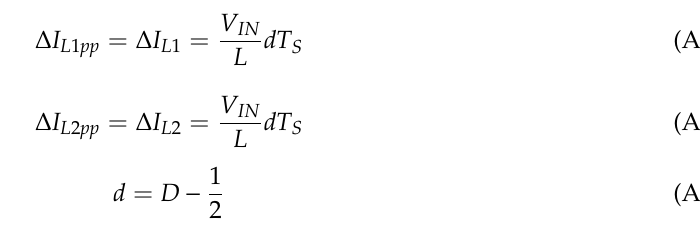
Figure A2. Input and inductor currents for 1/2 ≤ D < 1 .